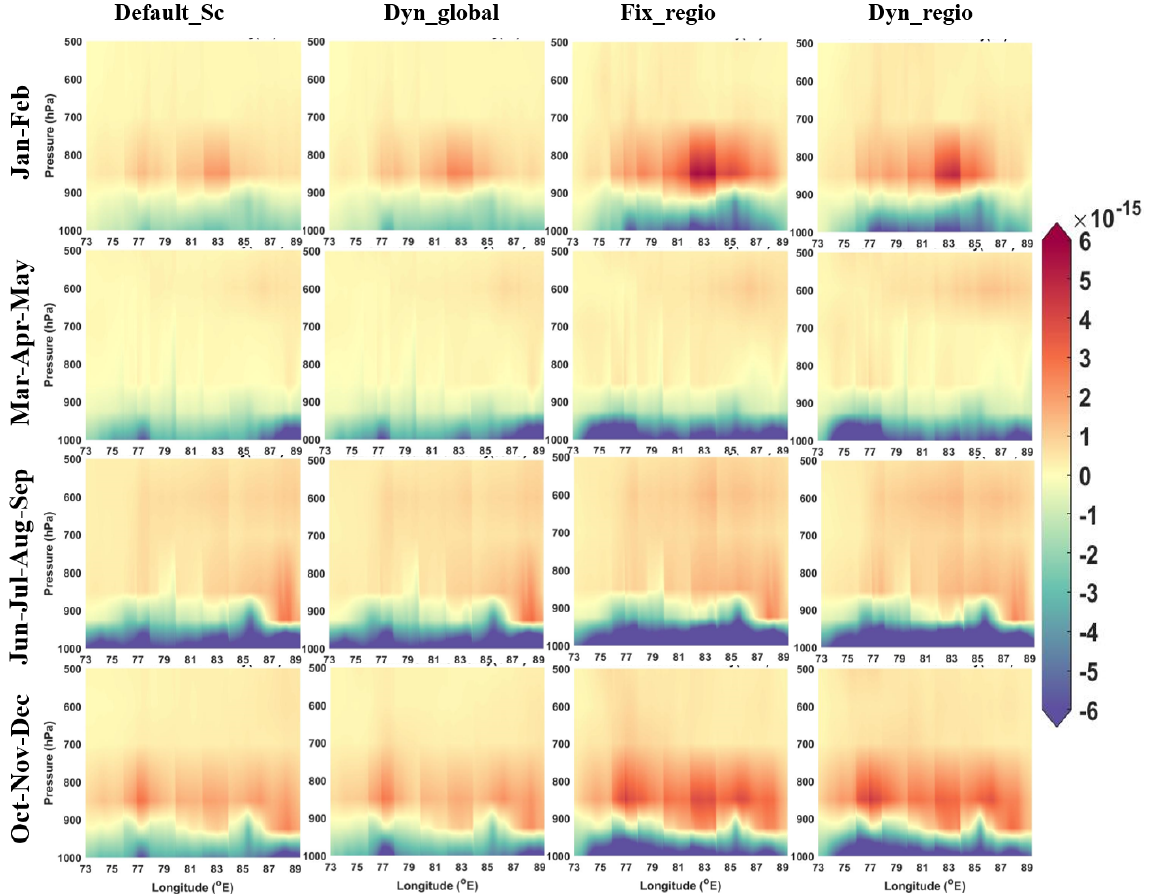
Figure 5. Seasonal distribution of the convective tendency (kgkg − 1 s − 1 ) of BC over the IGP for four distinct